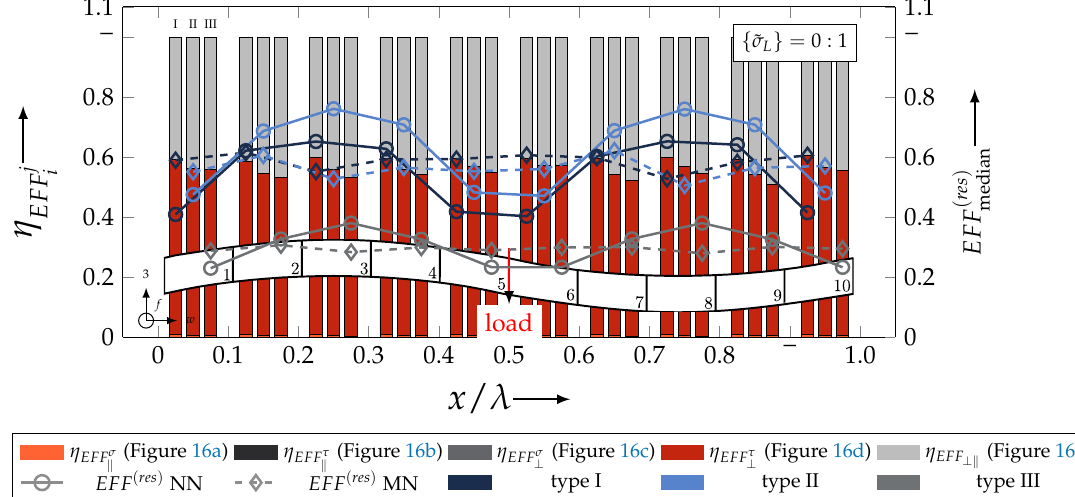
Figure 32. Illustration of the composition of FM by their fractions η rUC MN and on median resultant stress effort EFF I-III for rUC MN at load path { ˜ σ L } = 1:0. I-III